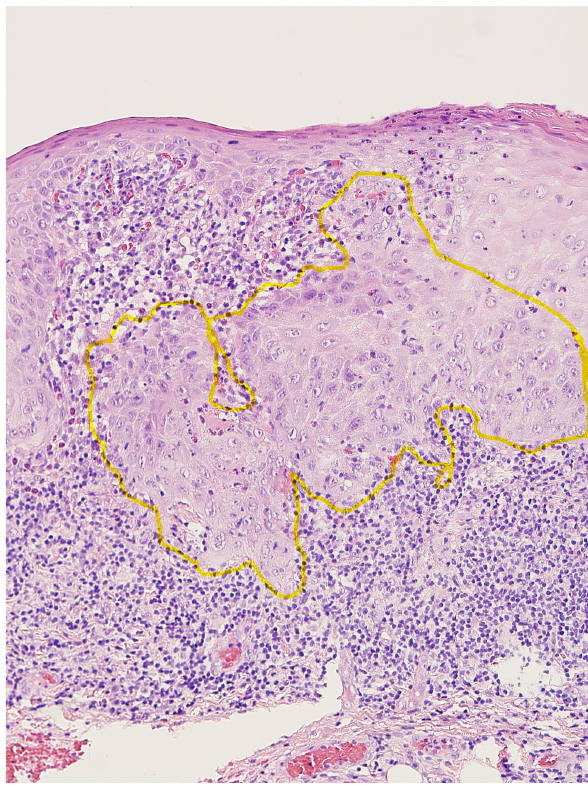
Fig. 2. Photo of histopathological examination, borders of car- cinoma delineated in yellow (HE